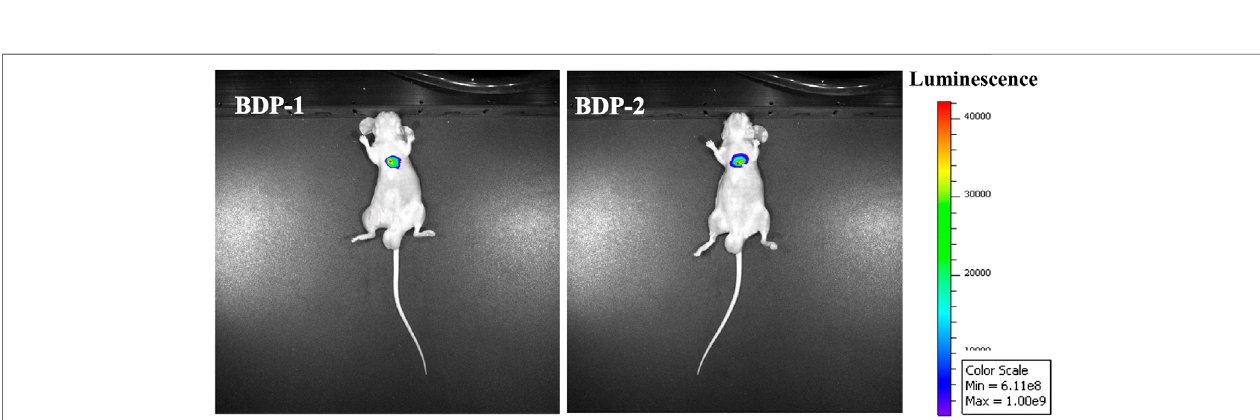
FIGURE 6 | In vivo fl uorescence images of mice after injection of BDP-1 (10 mM) and BDP-2 (10 mM).